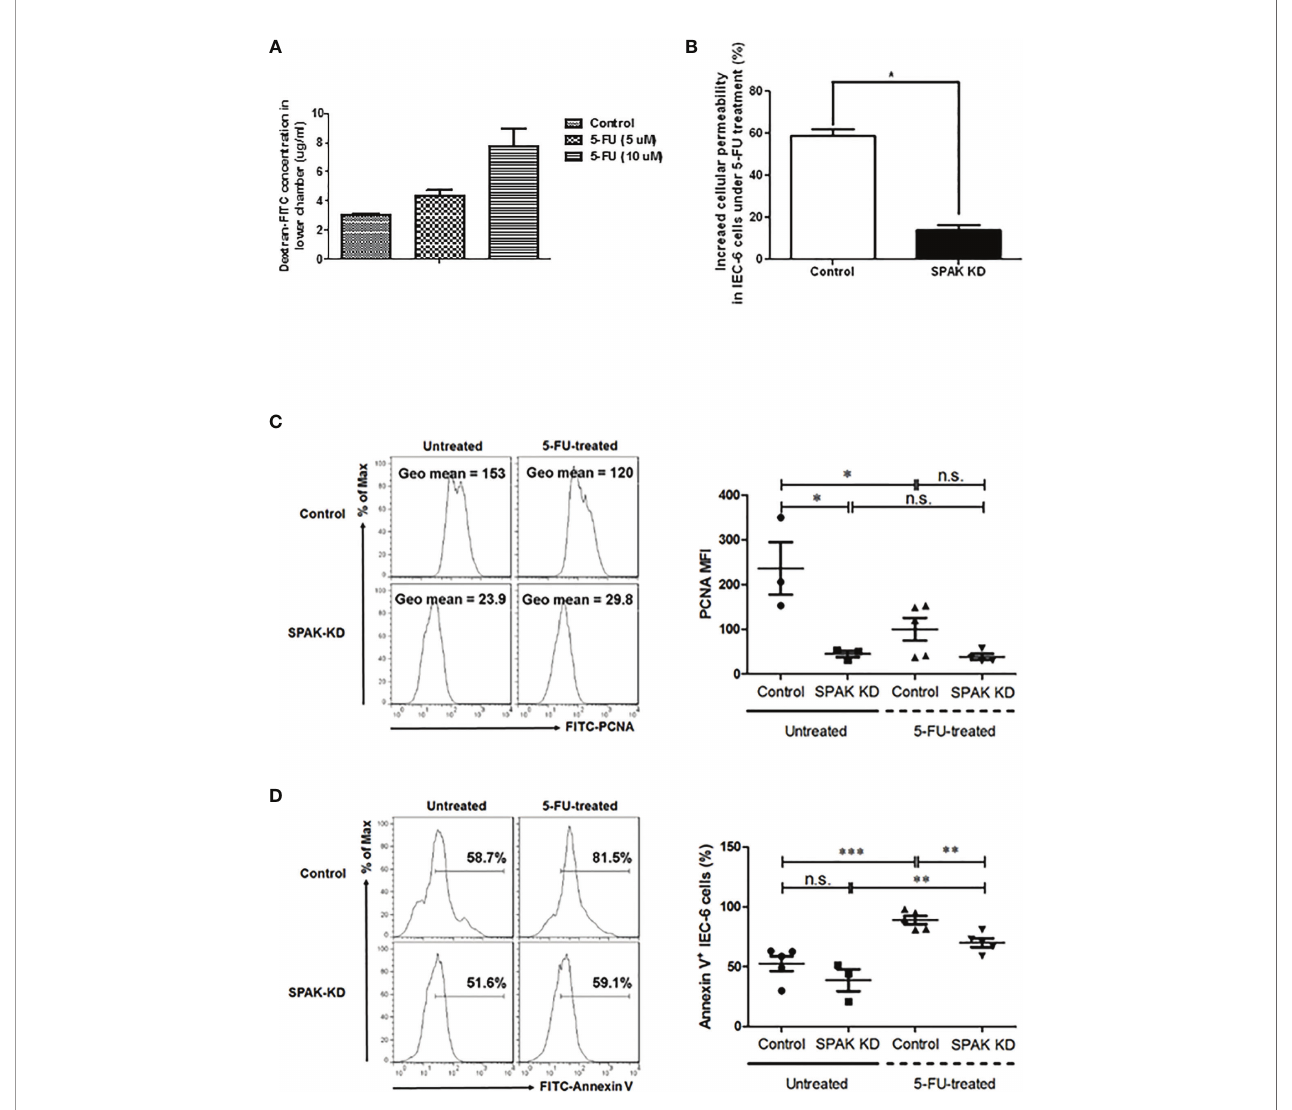
FIGURE 4 | (A, B) Cell permeability in murine epithelial IEC-6 cells following treatment of 5-FU. (A) After 5-FU treatment, permeability of IEC-6 cells increases in a concentration-dependent manner (5 and 10 m M). (B) siRNA-mediated knockdown of SPAK expression in IEC-6 cells blocks this increase in cell permeability compared to control cells treated with 5-FU (10 m M). (C, D) SPAK-knockdown modulates the effects of 5-FU treatment on the proliferation and survival of IEC-6 cells. Control and SPAK-KD IEC-6 cells were treated with 10 µM 5-FU and dimethyl sulfoxide (DMSO) solvent for 3 h, respectively. Untreated and 5-FU-treated control or SPAK-KD IEC-6 cells were analyzed to determine the mean fl uorescence index (MFI) of PCNA expression (C) and the percentage of annexin-V- positive cells (D) , respectively. (C) Representative fl ow cytometry assays are shown in the left panel, and the MFI of PCNA is shown in the right panel. (D) Representative fl ow cytometry assays (left panel) and the frequencies (right panel) of annexin-V-positive IEC-6 cells are presented. Data corresponding to MFIs or frequencies are representatives of at least three mice in each group, presented as the mean ± SEM. Two-tailed Student ’ s unpaired t -tests were used